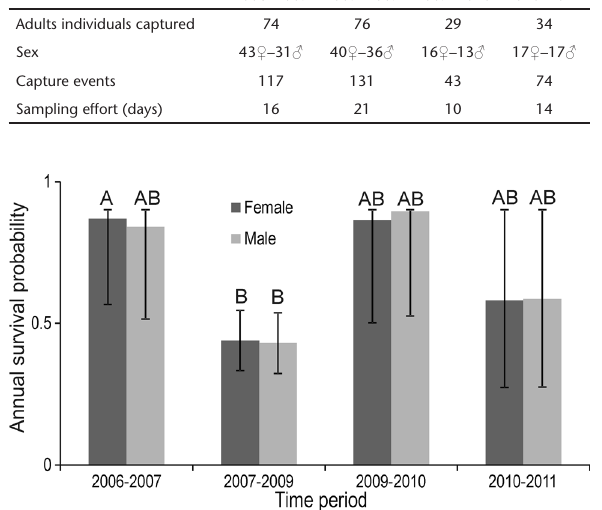
Figure 3. Temporal variation in annual survival probability of Chaeto- phractus vellerosus , estimated by multi-model inference based on the set of candidate CJS models. Error bars correspond to 95% confidence intervals, and letters (A and B) denote statistically ho- mogeneous subsets ( P > 0.05).